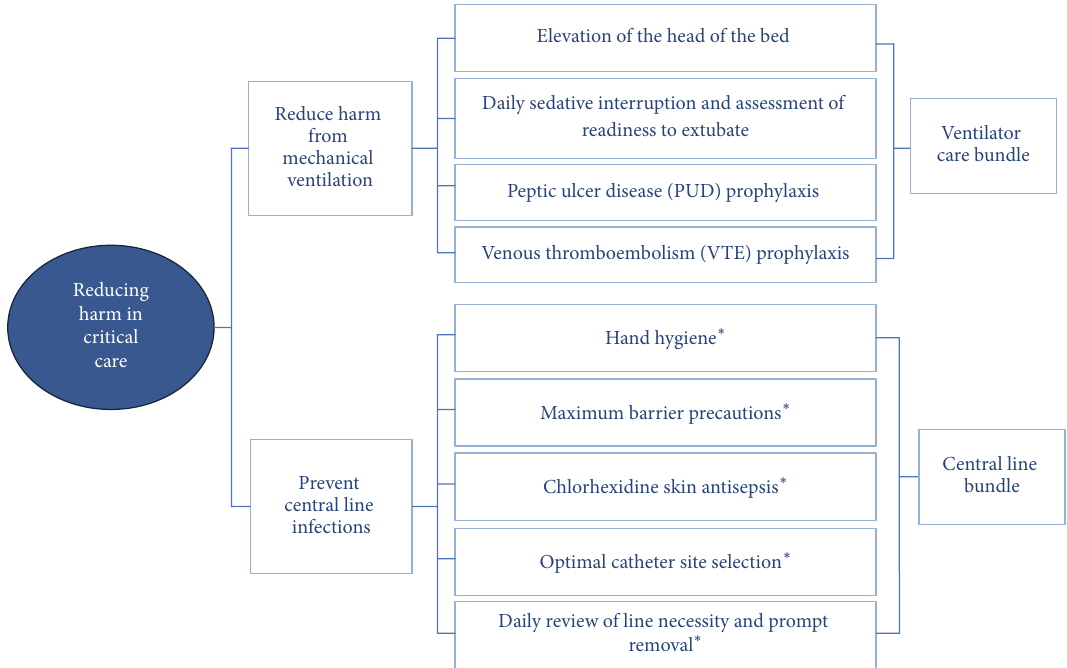
Figure 1: Example of ICU bundle of cares interventions. This study has been focused on aspects related to infection control similar to the central line bundle interventions ( ∗ ). Adapted from